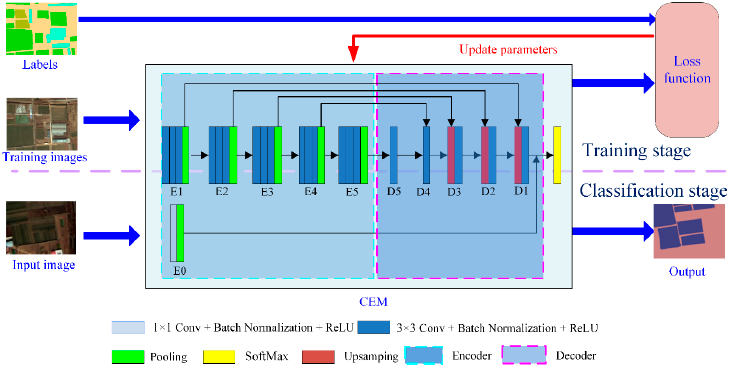
Figure 4. Structure of the proposed crop extraction model (CEM) model. ReLU: rectified linear unit; D: Decoder; E: Encoder.